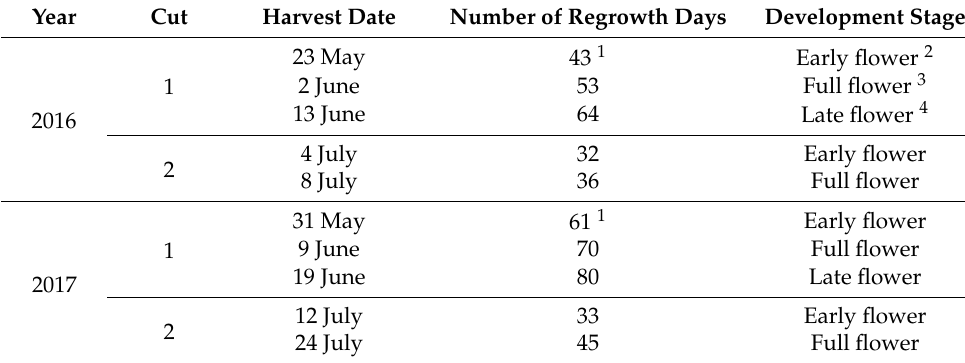
Table 1. Development stages and harvest times of fodder